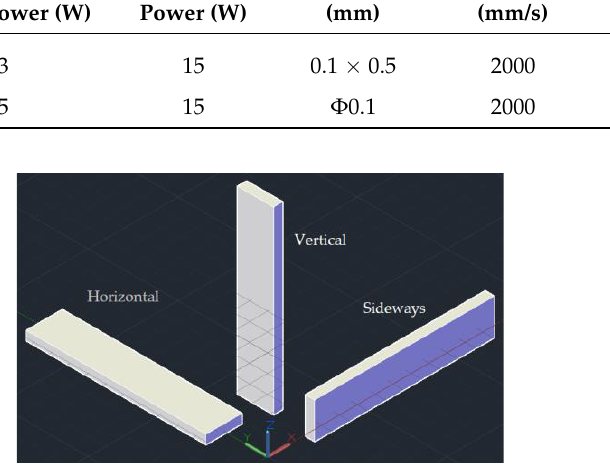
Figure 14. Diagram of the placement of the molded parts in three-dimensional space.